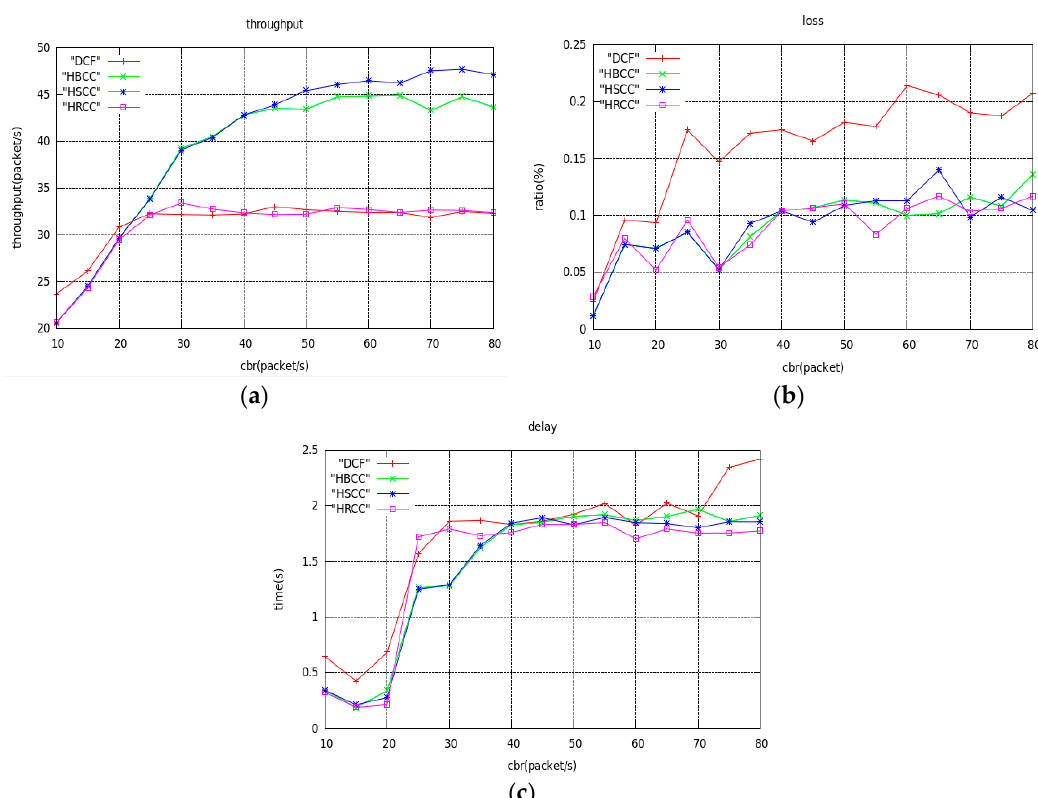
Figure 13. Performance simulation of aggregation topology networks. ( a ) The curves of average saturation throughput ; ( b ) The curves of buffer overflow loss ratio; ( c ) The curves of average end-to-end delay.